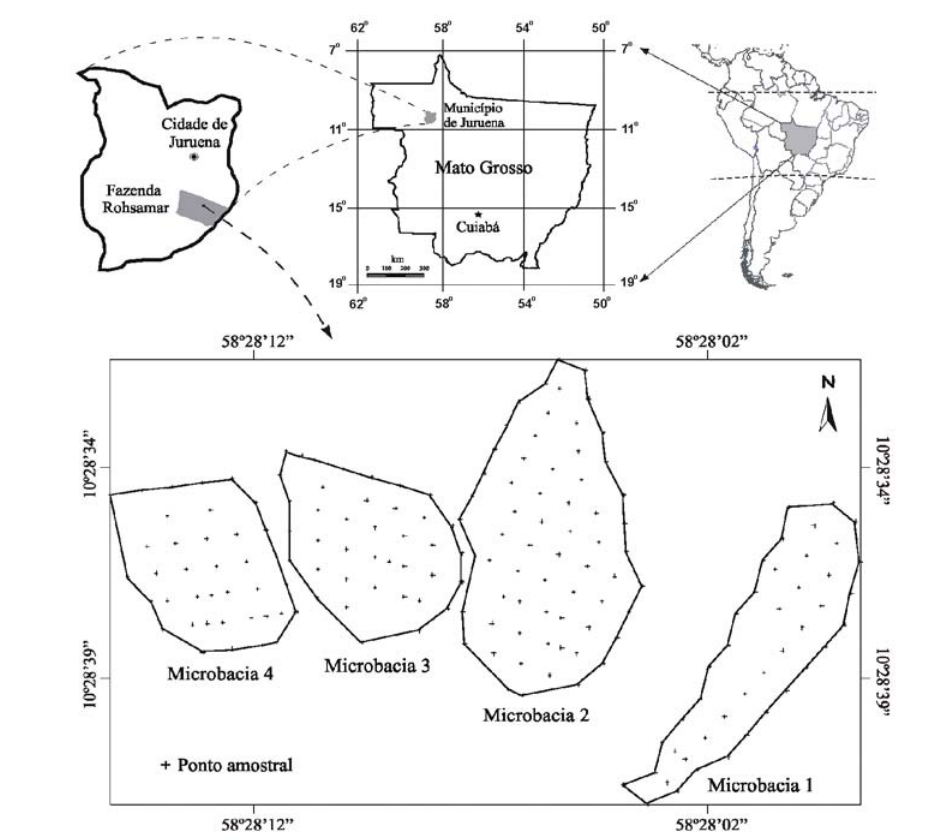
Figura 1. Localização das microbacias e distribuição dos pontos